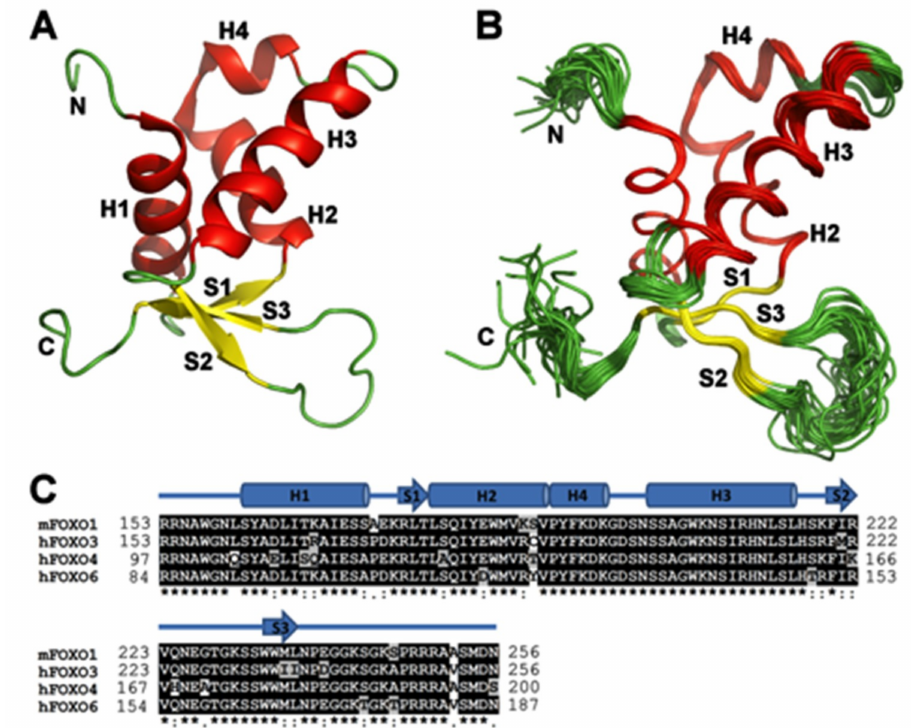
Figure 2. Solution structure of FOXO1-DBD. ( A ) Cartoon representation of the NMR solution structure of FOXO1-DBD showing residues 156-243. Secondary structure elements are labeled according to the nomenclature typical of the winged-helix motif [3]. ( B ) 30 superimposed FOXO1-DBD conformers of the NMR solution structure ensemble. ( C ) Sequence alignment of FOXO forkhead domains. Secondary-structure elements (based on the FOXO1-DBD) are indicated at the top. Protein sequences of mouse and human FOXO1-DBD are